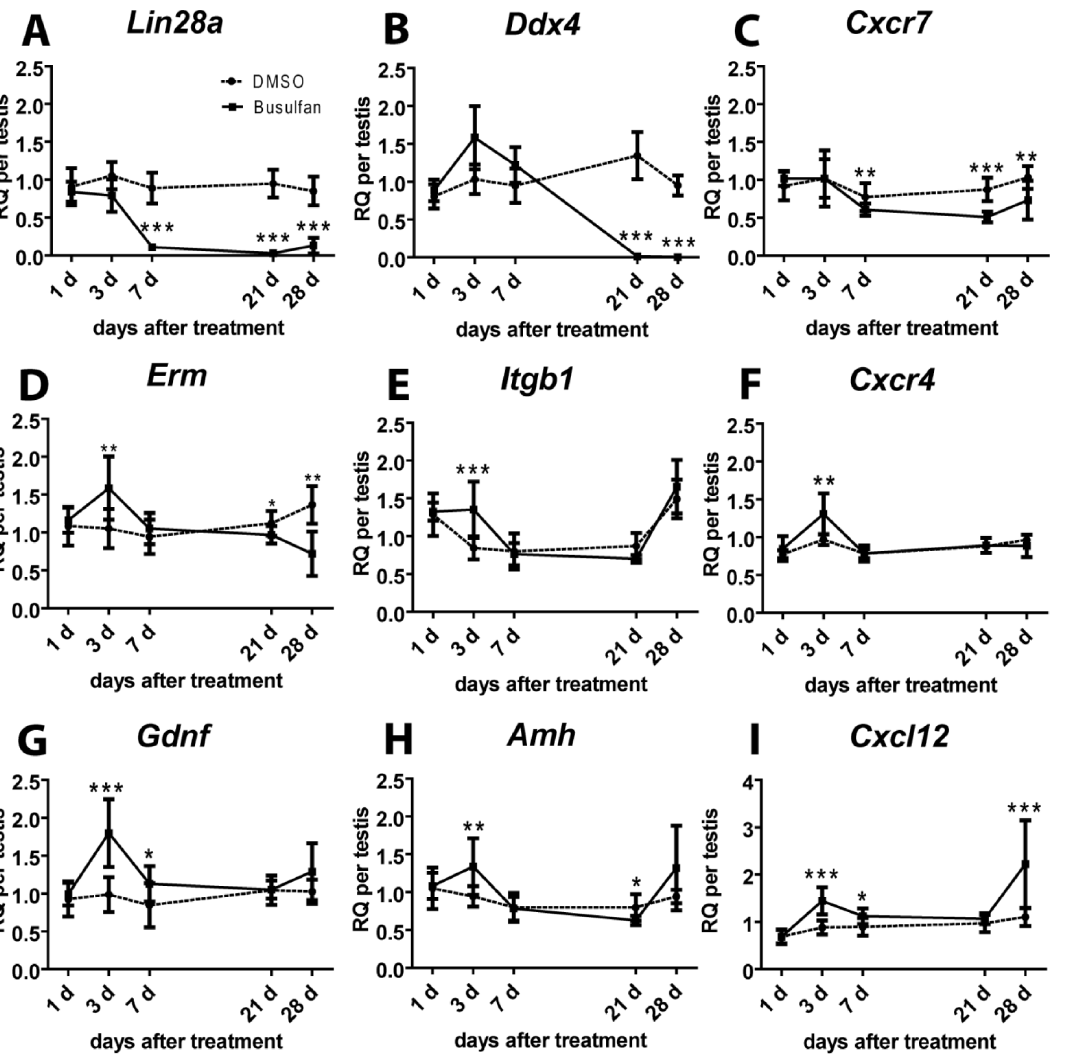
Figure 4. Gene expression patterns of Lin28a , Ddx4 and of SSC niche-associated factors in adult mouse testes after cytotoxic treatments. Changes in transcript levels of Lin28a (A), Ddx4 (B), Cxcr7 (C), Erm (D), Itgb1 (E), Cxcr4 (F), Gdnf (G), Amh (H) and Cxcl12 (I) on days 1, 3, 7, 21 and 28 after DMSO ( N ) and busulfan ( & , 38 mg/kg) treatment (n 5 10 per time point and treatment). Results were calculated using luciferase as external standard and values from the sham-treated control group (n 5 8) as calibrator and are presented as fold change in gene expression per testis (RQ per testis). Significant differences between the DMSO and the busulfan groups are marked with asterisks (*, P 5 0.01 to 0.05; **, P 5 0.001 to 0.01 or ***, P ,